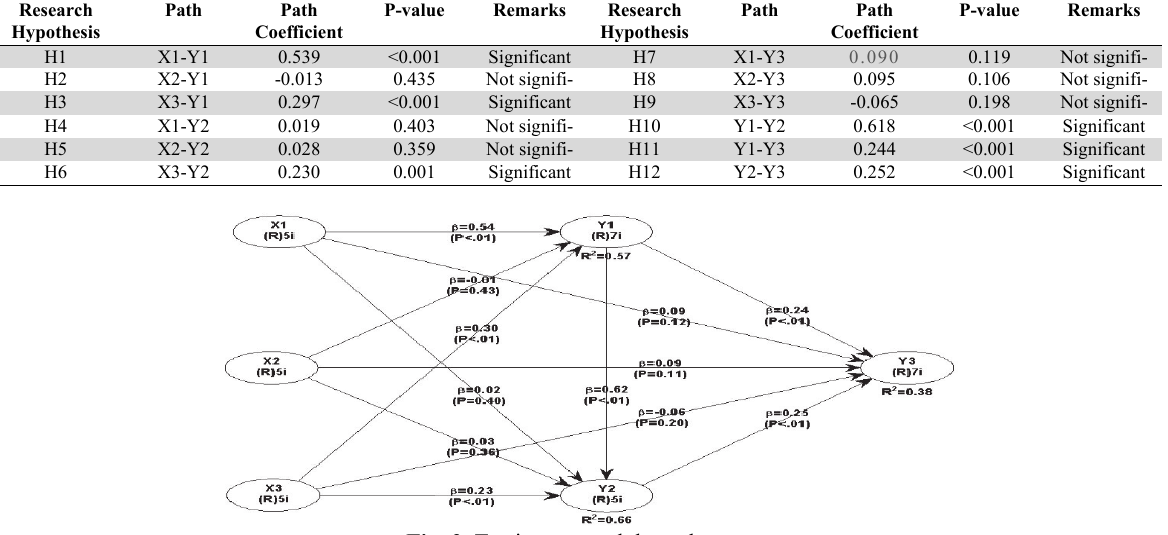
Testing research hypotheses